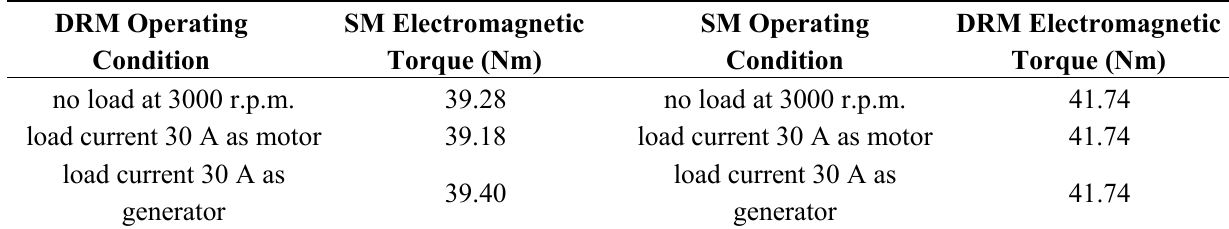
Table 2. Comparison of electromagnetic